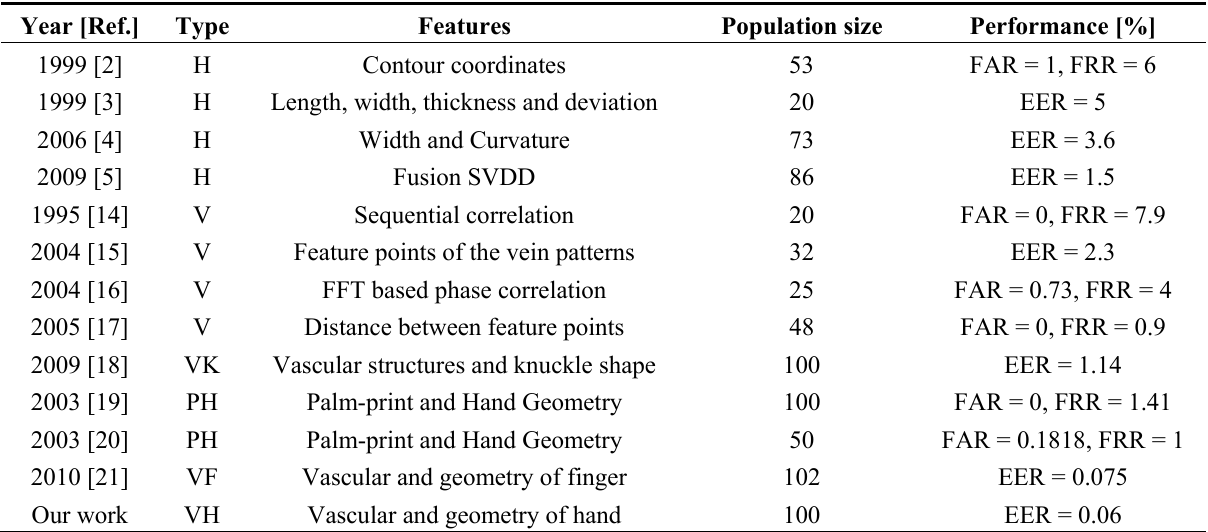
Table 1. Comparative biometric example (dorsum hand geometry, dorsum hand vascular pattern and multi-model